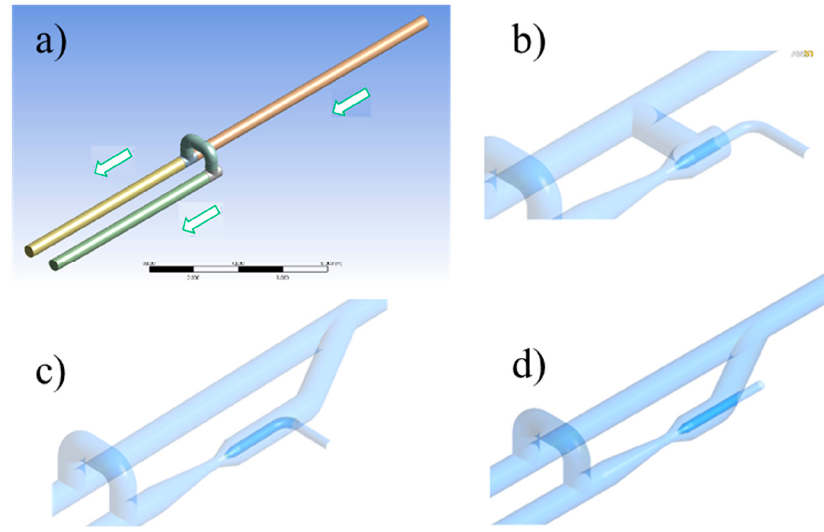
Figure 9. Fluid physical domain ( a ) Original loop, ( b ) Jet pump standard installation, ( c ) Jet pump option 1, ( d ) Jet pump option 2 [3].